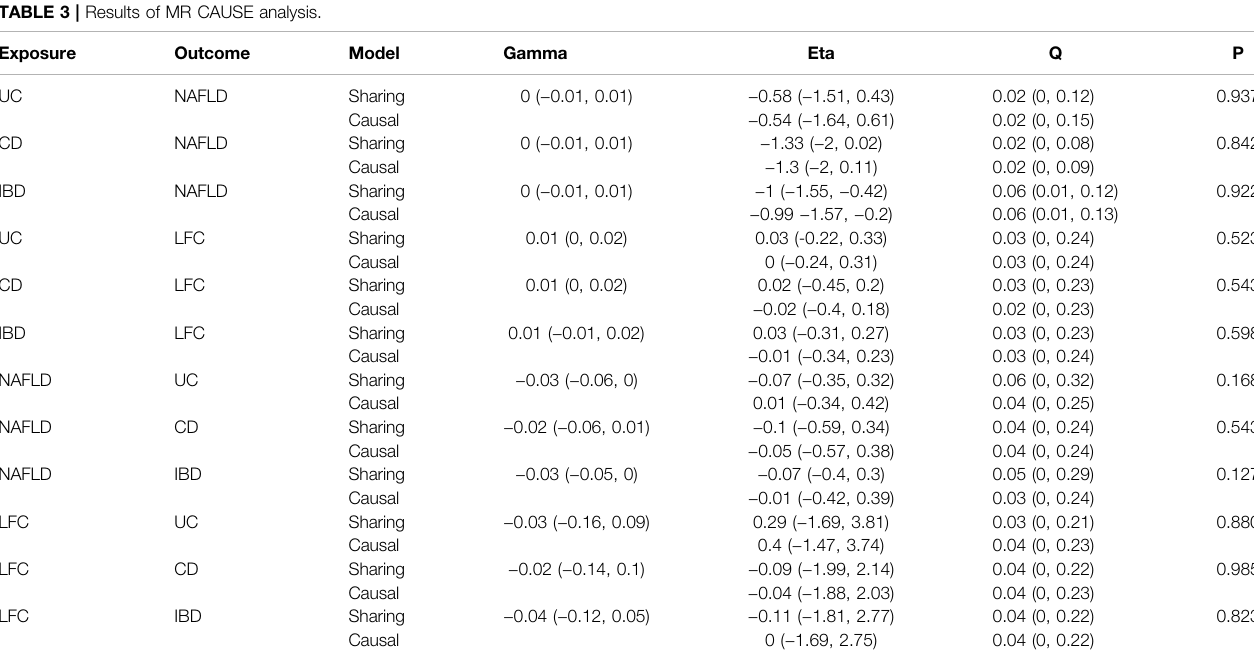
TABLE 3 | Results of MR CAUSE